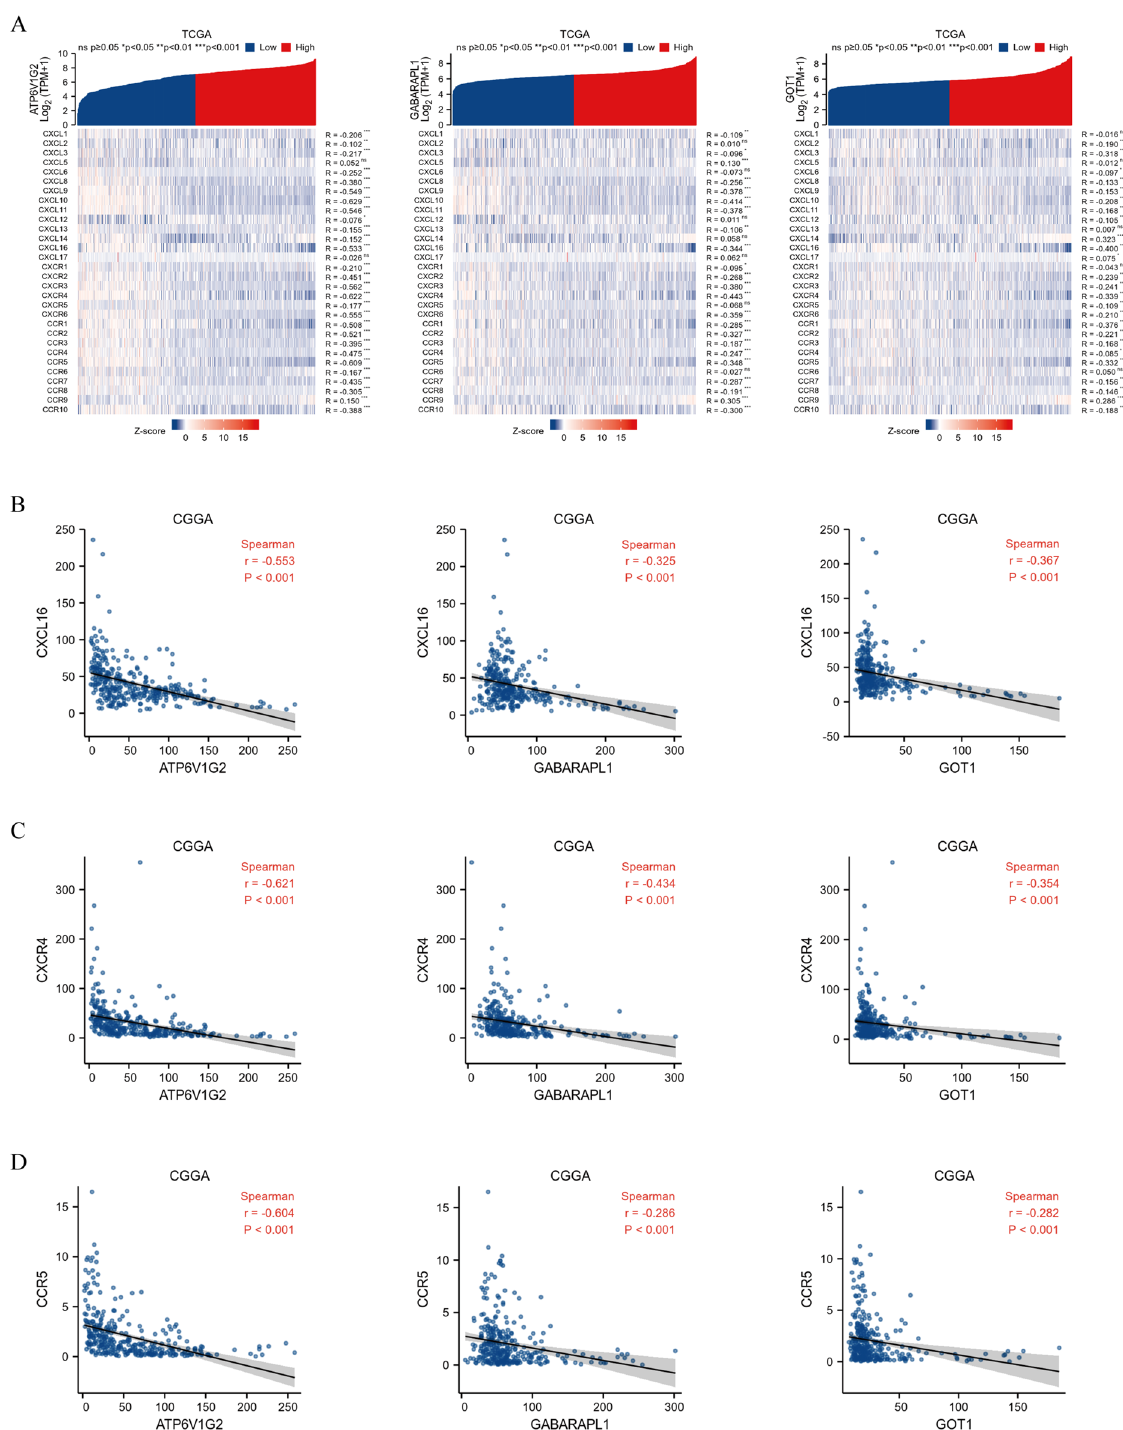
Figure 7. Visualization of the chemokines analysis. Association of hub genes with chemokines and related receptors in TCGA database ( A ). Association of hub genes with CXCL16 ( B ), CXCR4 ( C ) and CCR5 ( D ) in CGGA